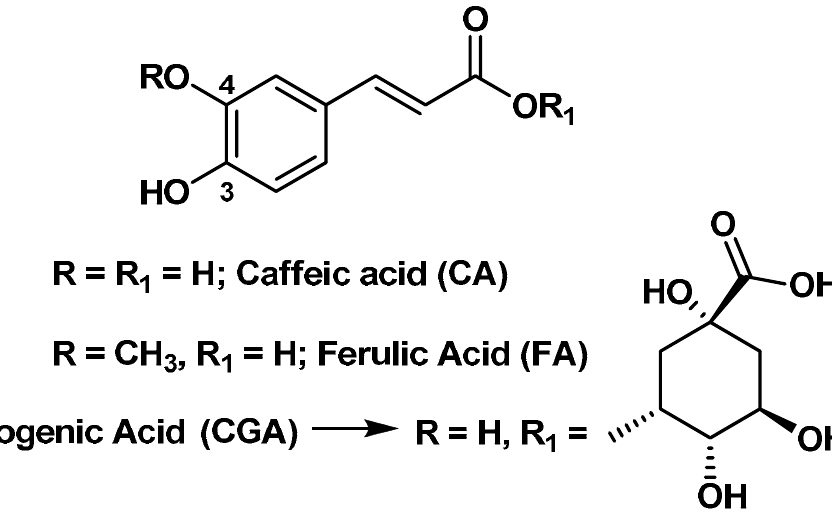
Figure 5. Chemical structure of natural phenols with trans -cinnamic acid